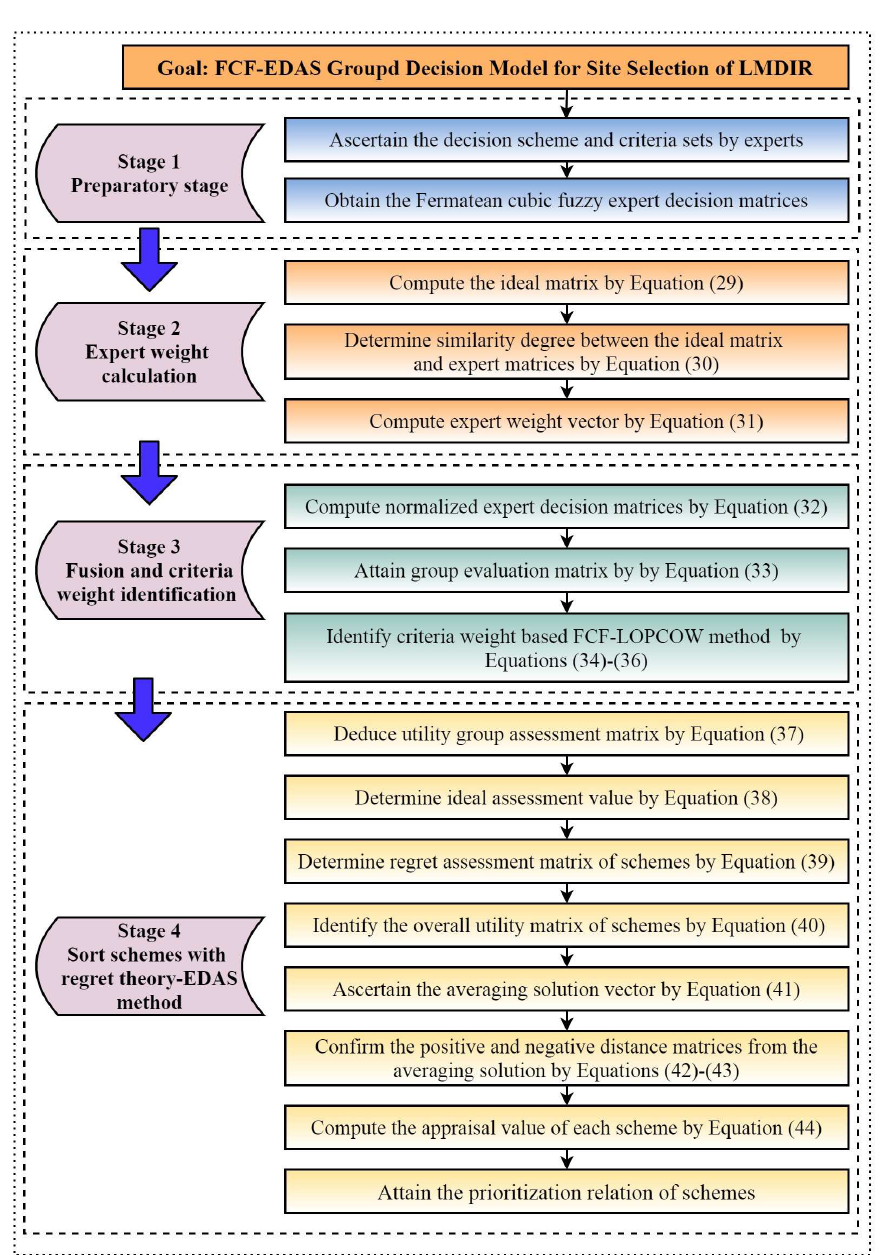
Figure 1. The propounded FCF-EDAS group decision